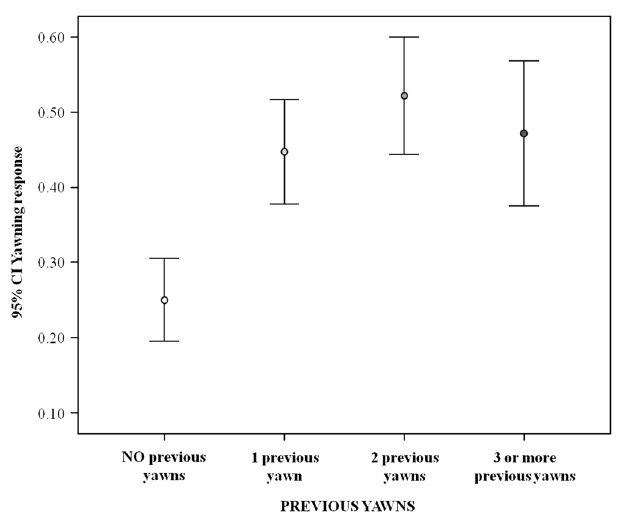
Figure 3. Error bars (mean, 95% confidence interval) showing the occurrence of the yawning response (Y axis) as a function of the number of additional yawns emitted by subjects other than the yawn emitted by the last trigger (X axis). The variable has a significant main effect on the yawning response (results of Model 1 included in Table 1), with the response being highest when one or more additional yawn had been emitted compared to no additional yawn (Tukey post-hoc test with Bonferroni correction; no additional yawn versus other conditions: 0.001 < p ≤ 0.045. CI confidence